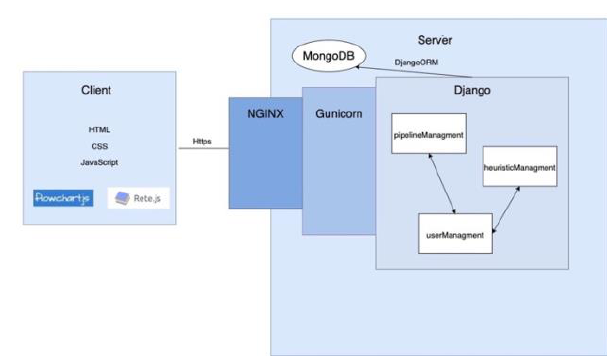
Figure 8. KoopaML